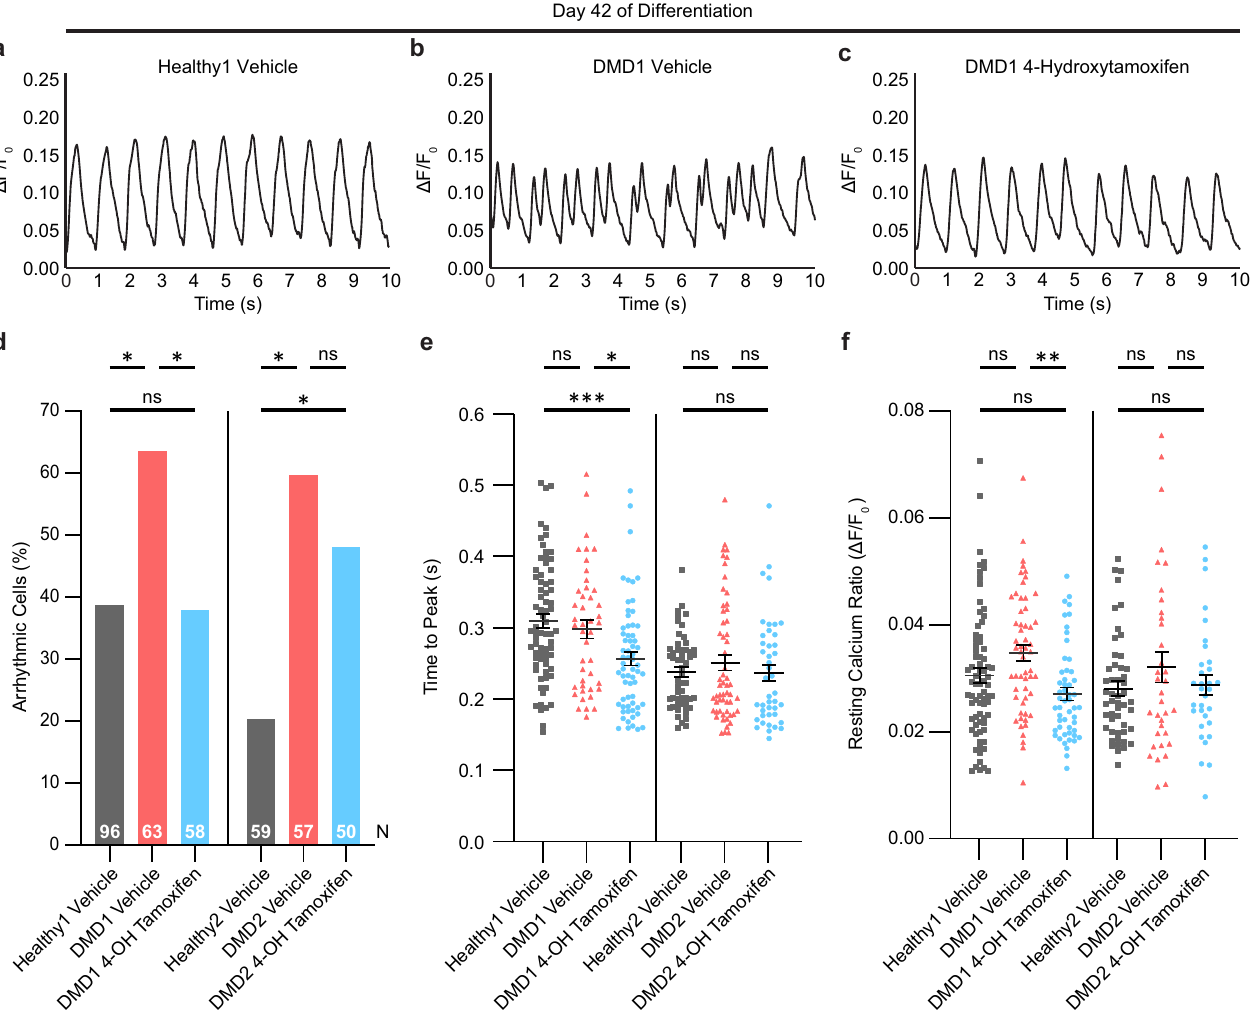
Fig. 6 Treatment with 4-hydroxytamoxifen reduces the percentage of arrhythmic cells and lowers resting calcium ratio. a – c Representative calcium transients in iPSC-CMs on day 42 of differentiation. Calcium imaging was performed after cells were treated every 3 days beginning on day 30. d Percentage of cells exhibiting arrhythmic events on day 42. Pearson ’ s chi-square test was used to compare frequencies of arrhythmic cells. Z-test with Bonferroni correction was used for pairwise comparisons. n = 3 biological replicates, N indicates total number of cells analyzed. * P < 0.05. e , f Time to peak and resting calcium ratio on day 42. Cells were treated every 3 days beginning on day 30 of differentiation. Data represent mean ± SEM. Statistical signi fi cance determined by one-way ANOVA and Tukey test for post hoc comparison. * P < 0.05, ** P < 0.01, ns (nonsigni fi cant). n = 3 biological replicates, N = 32 – 75